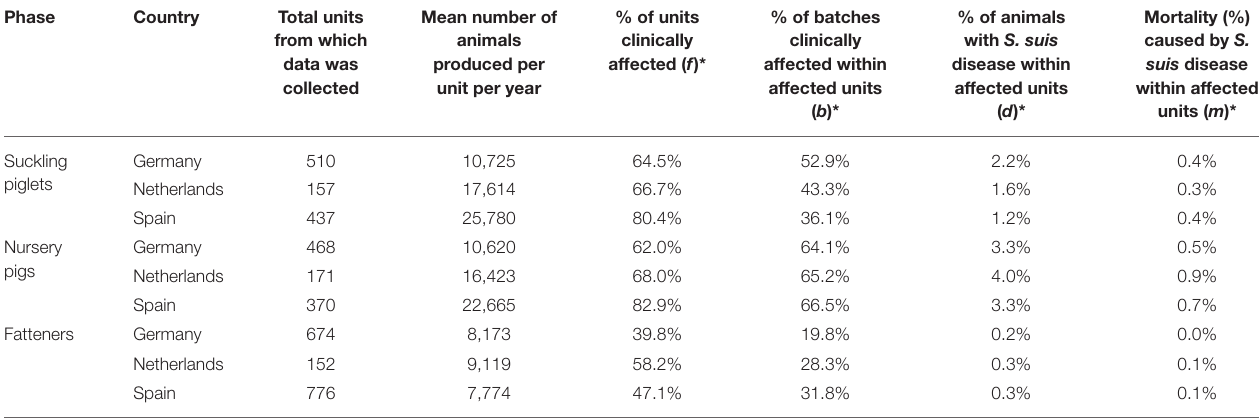
% of batches % of animals Mortality (%) Mean number of % of units clinically with S. suis caused by S. from which animals clinically suis disease affected within disease within data was produced per affected ( f )* affected units affected units within affected collected unit per year ( b )* ( d )* units ( m )*